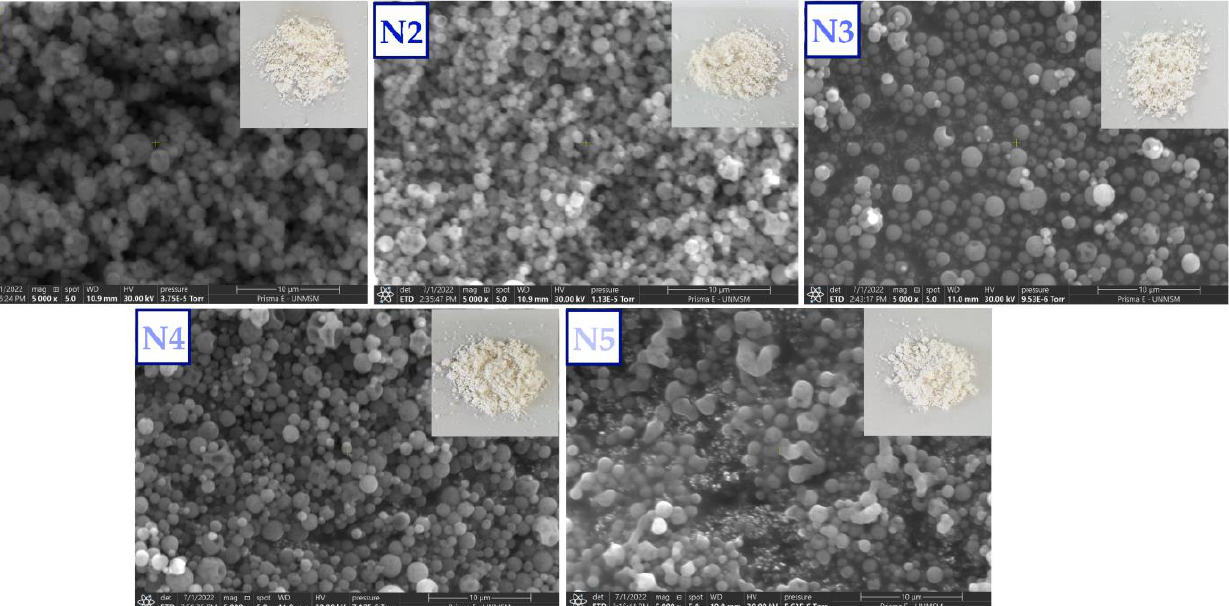
Figure 5. SEM images of propolis nanoencapsulates N1, N2, N3, N4, and N5 at 5000× magnification.